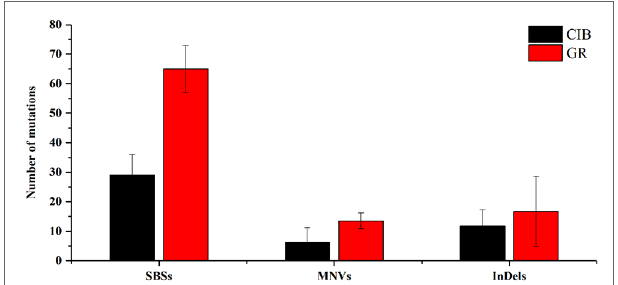
FIGURe 2 | Average numbers of different mutation types induced by CIBs and GRs in all the mutants. SBSs, single base substitutions; MNVs, multiple nucleotide variants. **Represents significant at 0.01 level; *represents significant at 0.05 level.